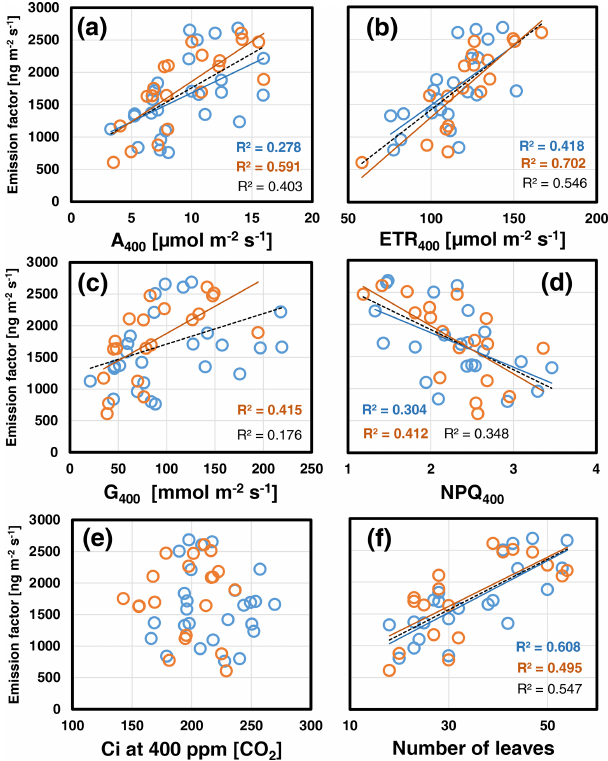
Figure 1. Scatterplots of the foliar emission factors measured at the beginning of CO 2 ramping at 400ppm [CO 2 ] and assay tempera- tures of 30 ◦ C (blue) and 35 ◦ C (red) against simultaneously mea- sured photosynthetic variables (a–e) and the number of leaves per plant (f) . Lines with determination coefficients R 2 show best-fit re- sults from Pearson correlation analyses with P< 0 . 05. Dashed lines and R 2 in black are from pooled data. See Table S3a in Supple- ment 2 for more